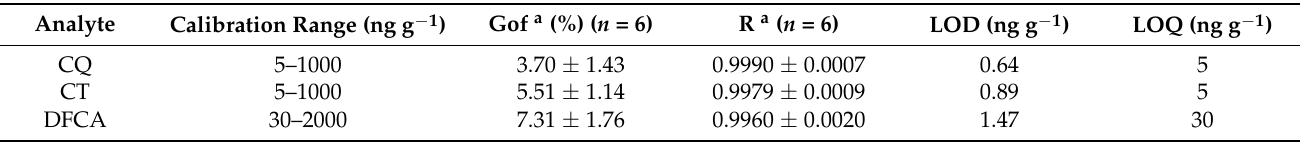
Table 2. Results of the evaluation of linearity (goodness-of-fit coefficient (gof), correlation coefficient (r), mean ± standard deviation), limit of detection (LOD), and limit of quantification (LOQ) of cefquinome (CQ), ceftiofur (CT) and desfuroylcef- tiofuracetamide (DFCA) in porcine feces.